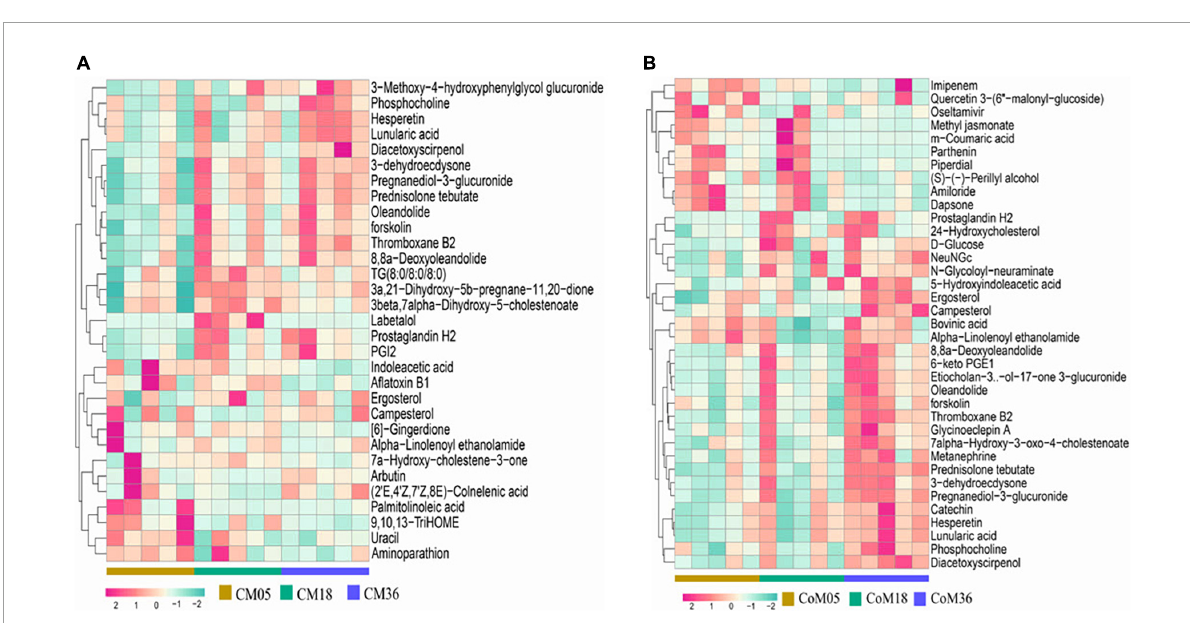
FIGURE5 Heat map of metabolites in the cecum (A) and colon (B) of Mongolian cattle in different age groups. Relative percent abundances (square root rescaled) of top 30 metabolites in cecum ( n = 15) and colon ( n = 15)